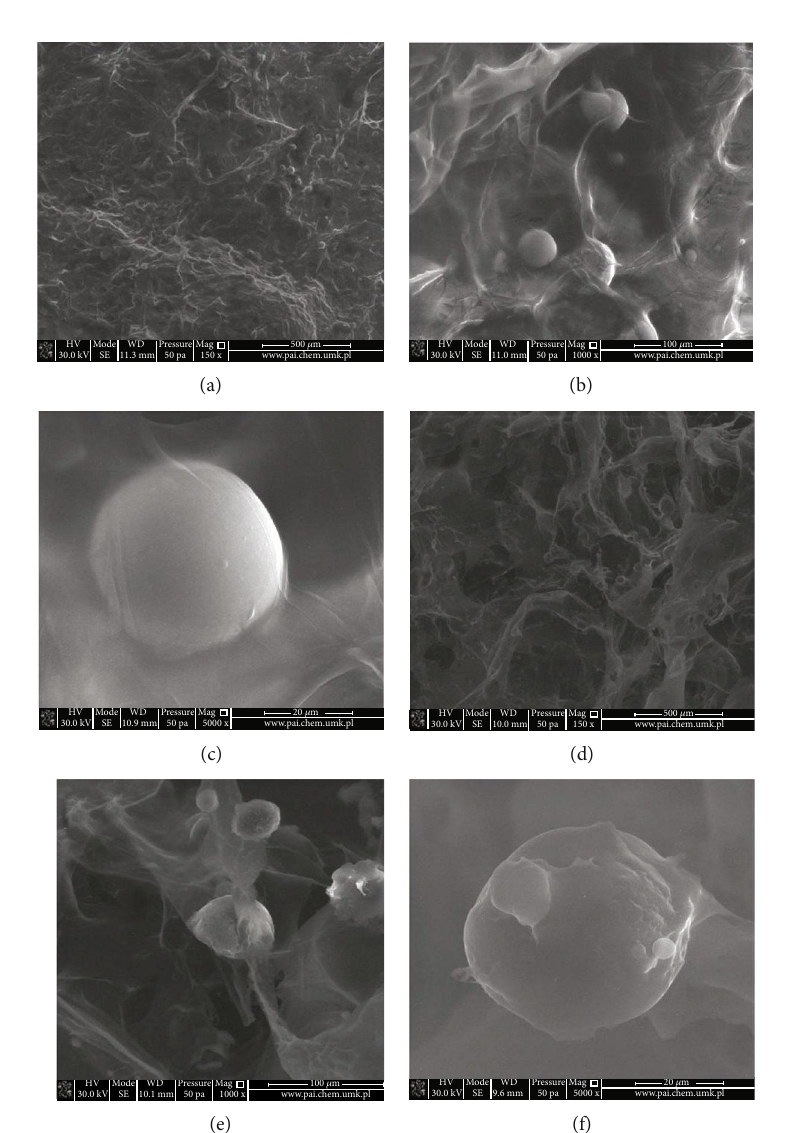
Figure 63: SEM micrographs of collagen matrix containing poly(vinyl) alcohol microcapsules loaded with retinyl palmitate: (a) – (c) Col/ PVA 1:1; (d) – (f) Col/PVA 1:10